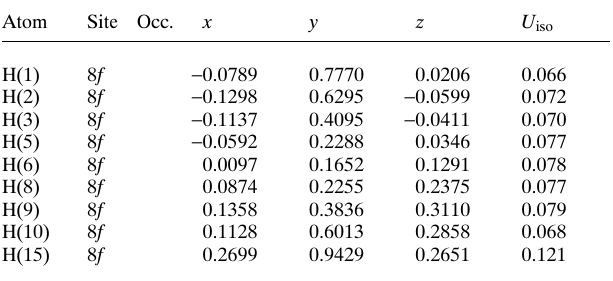
Table 2. Atomic coordinates and displacement parameters (in Å 2 )